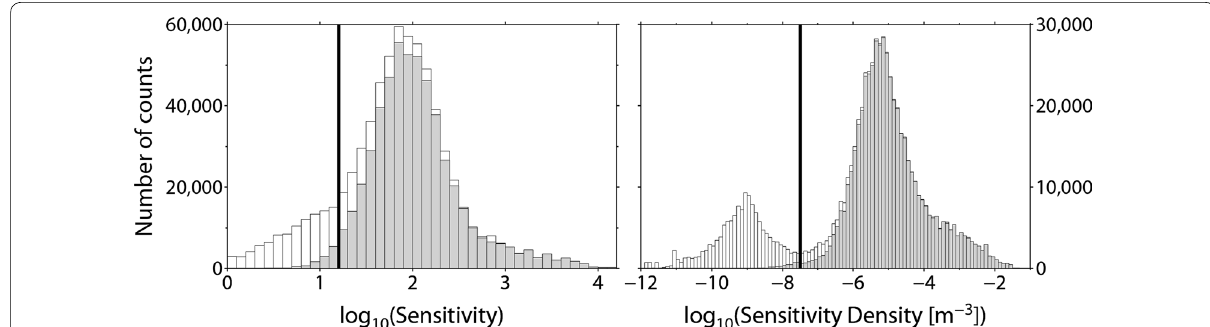
Fig. 3 Histograms of the absolute sensitivities (left panel) and absolute sensitivity densities (right panel) for the core region (grey) and exterior (white). The bins cover 0.1 intervals. The sensitivity density is divided by the volume of the corresponding element to avoid biasing from large elements. The setup criteria (10 1.2 in absolute sensitivity and 10 − 7.5 in sensitivity density) of the lower limit of relatively high‑sensitive elements are indicated by thick lines